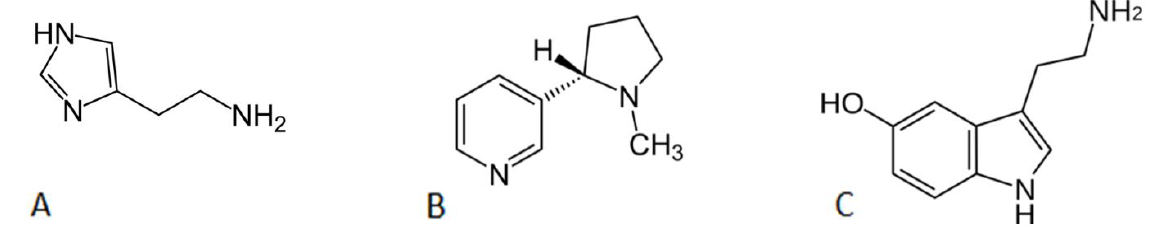
Figure 1. Chemical structure of: ( A ) histamine; ( B ) serotonin and ( C ) L